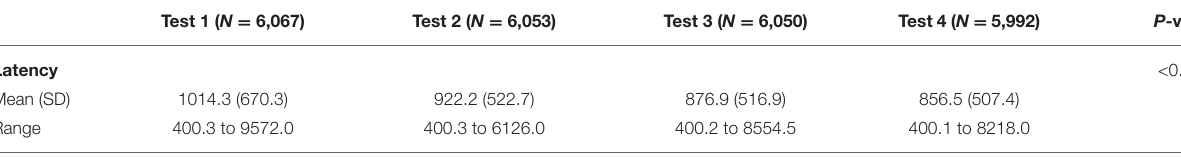
TABLE 8 | Test order vs. latency measurements.